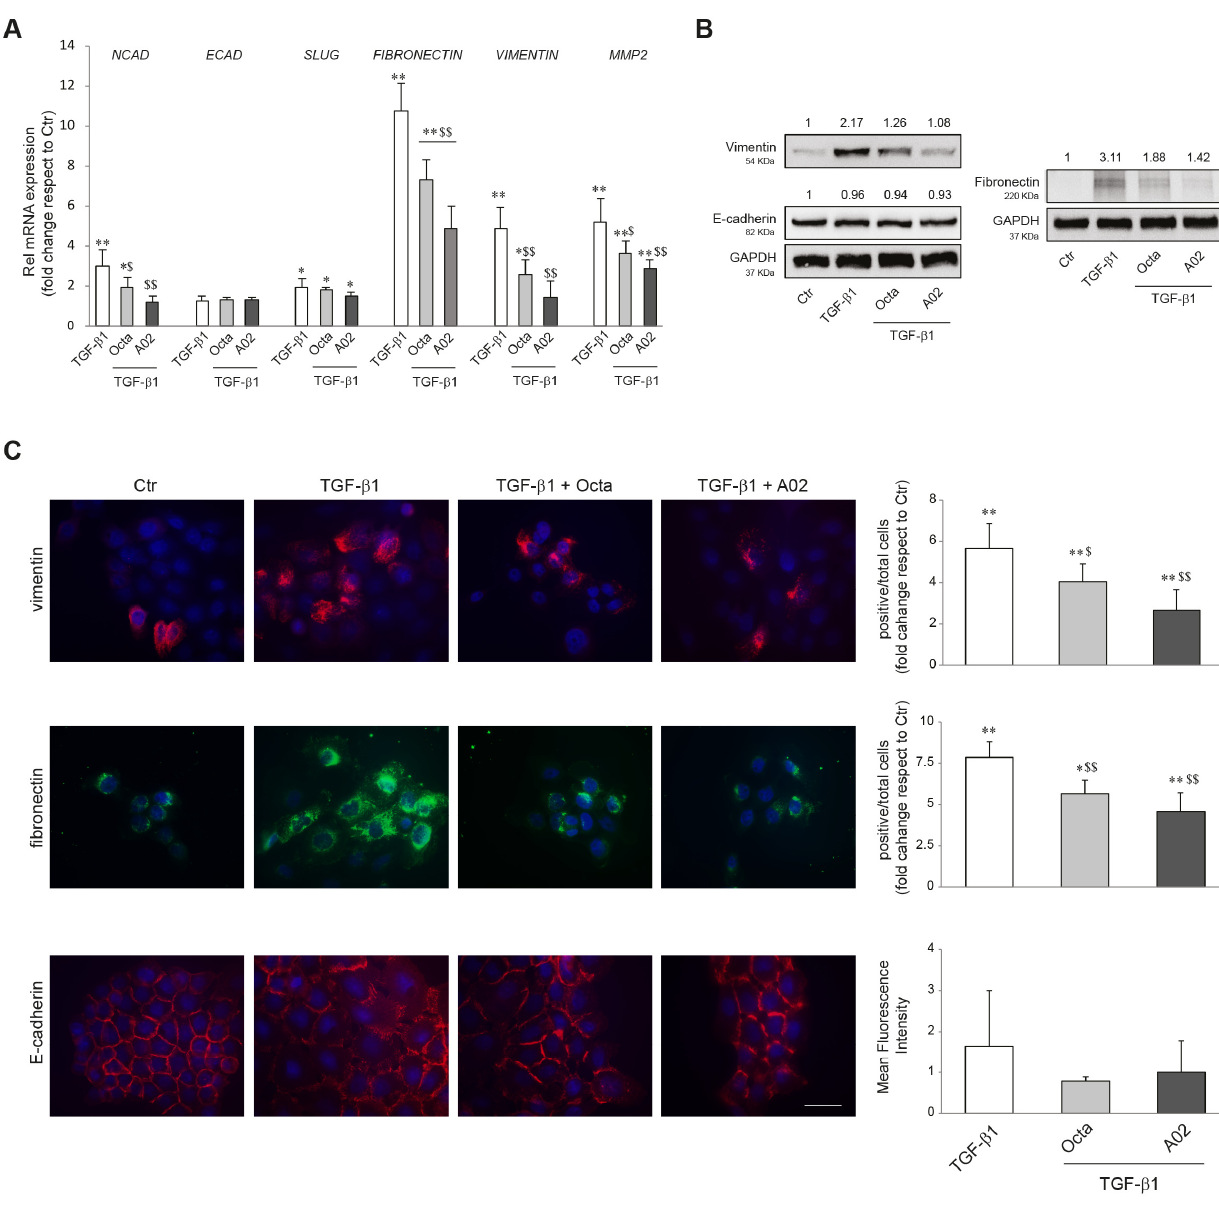
Figure 3. Effects of A02 and Octa on the TGF- β 1-induced EMT in A431 cells. ( A ) Real-time RT-PCR analysis of NCAD, ECAD, SLUG, FIBRONECTIN, VIMENTIN, and MMP2 in A431 pre-incubated with Octa or A02 (90 µ M) for 1 h and then treated with TGF- β 1 (15 ng/mL). All mRNA values were normalized against the expression of GAPDH and were expressed relative to untreated control cells. The data in the graphs are the mean ± SD of three independent experiments (* p < 0.05, ** p < 0.01 vs. untreated control; $ p < 0.05, $$ p < 0.01 vs. TGF- β 1-treated cells). ( B ) Western blot analysis of vimentin, E-cadherin, and fibronectin protein expression in A431 pre-incubated with Octa or A02 (90 µ M) for 1 h and then treated with TGF- β 1 (15 ng/mL) for 72 h. GAPDH was used as an endogenous loading control for Western blot analysis. Densitometric scanning of band intensities was performed to quantify the change in protein expression. Data represent the mean ± SD of three independent experiments and are expressed as fold change with respect to untreated control cells (control value taken as 1-fold in each case). ( C ) Immunofluorescence and quantitative analysis of vimentin, fibronectin, and E-cadherin in A431 cells. Results are expressed as fold change of positive cells or mean fluorescence intensity with respect to control. Nuclei were counterstained with DAPI. Bar: 20 µ m. (* p < 0.05, ** p < 0.01 vs. control; $ p < 0.05 vs. TGF- β 1; $$ p < 0.01 vs. TGF- β